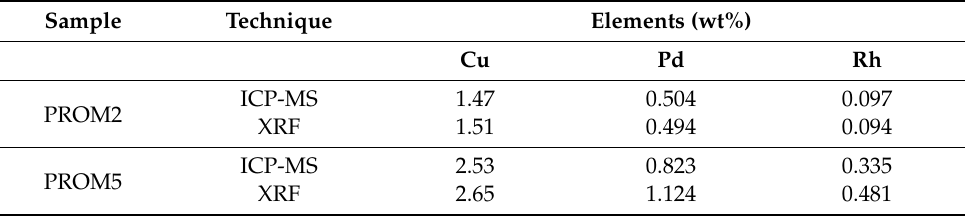
Table 4. Comparison of inductively coupled plasma mass spectrometry (ICP-MS), X-ray fluores- cence (XRF), techniques for catalyst samples PROM2 and PROM5.